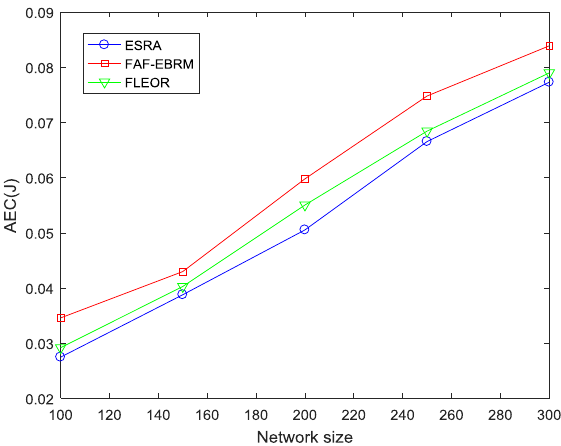
Figure 8. The AEC comparisons with varying network size.